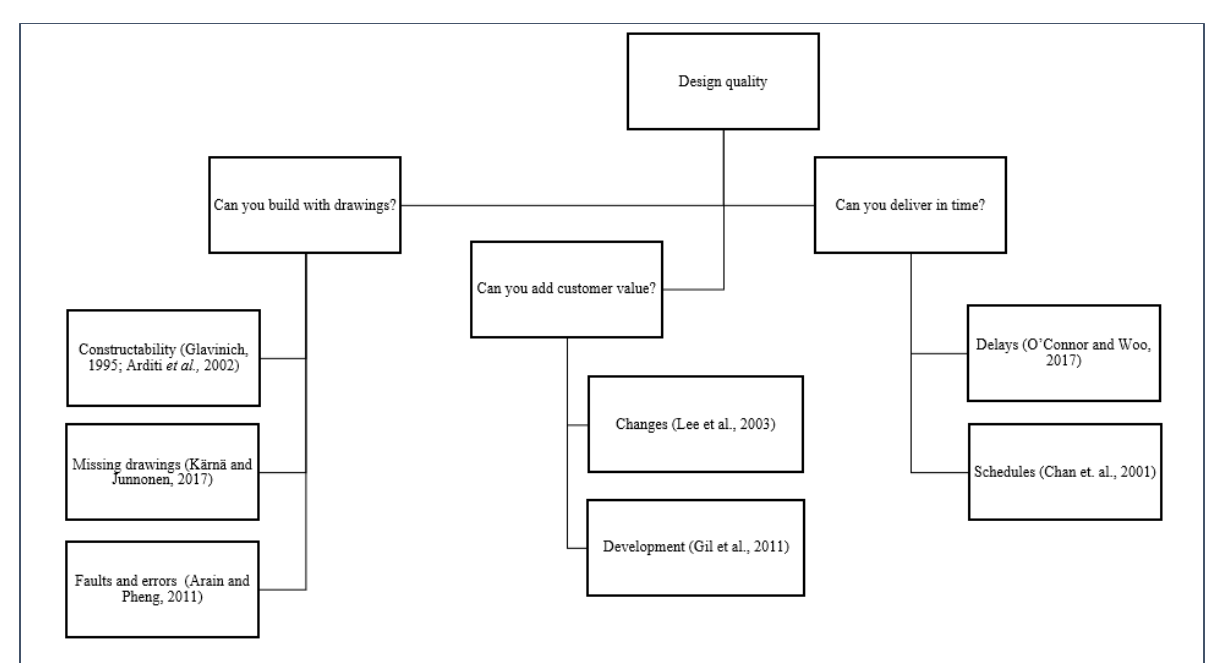
Figure 1. Conceptual framework of design quality key factors used in this study.